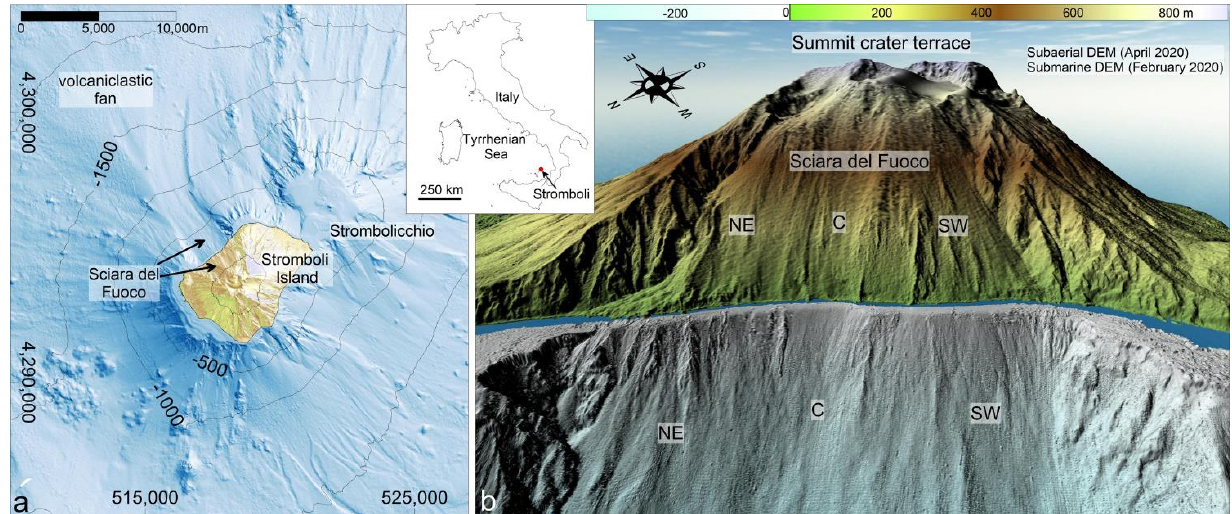
Figure 1. ( a ) Shaded relief and contour map (equidistance 500 m) of Stromboli volcano, with location of the Sciara del Fuoco using the April 2020 and February 2020 digital elevation models for the subaerial and submarine parts, respectively; the inset shows the location of Stromboli volcano (red point) in the Tyrrhenian Sea. ( b ) This is a 3-D image of the Sciara del Fuoco collapse scar, which can be morphologically divided in the north-eastern (NE), central (C), and south-western (SW) sectors and in the subaerial (coloured) and submarine (grey) parts.